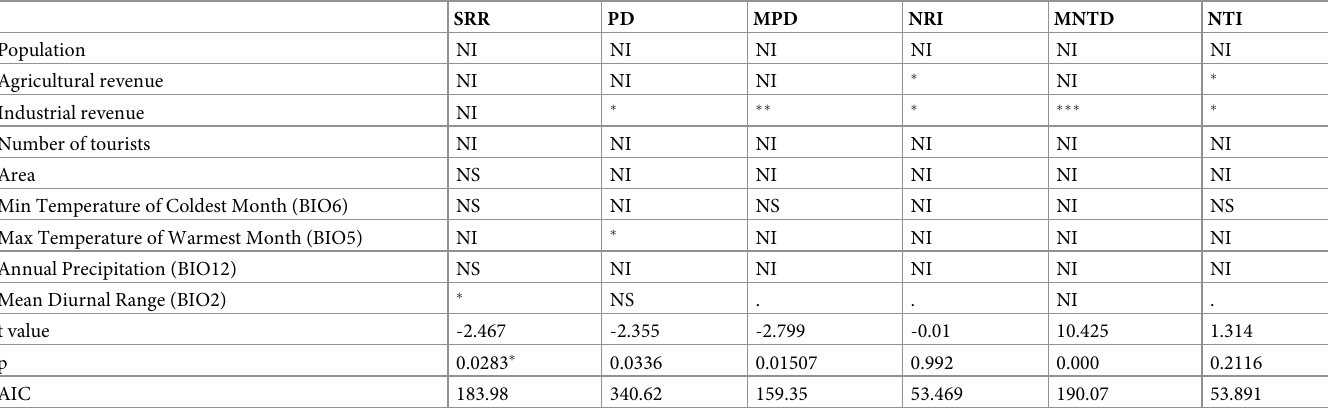
Table 6. Results of generalized linear model (GLM) analyses between the phylogenetic diversity index and anthropogenic/natural environment variables.